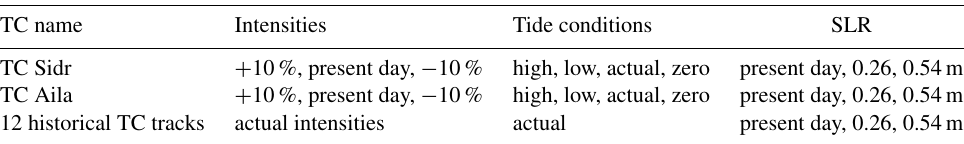
Table 3. Parameters considered for ensemble projection of storm surge inundation, which includes the TC intensities, tidal conditions and the SLR scenarios.